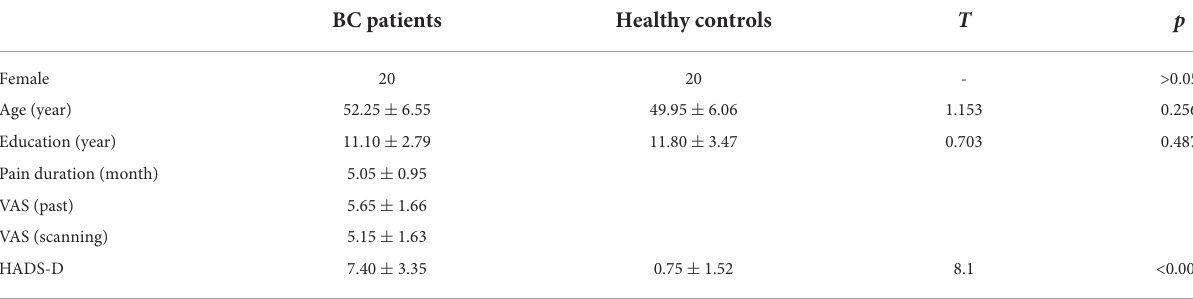
TABLE 1 Demographic and clinical data of breast cancer (BC) patients and healthy controls (HC) (mean ± SD). BC